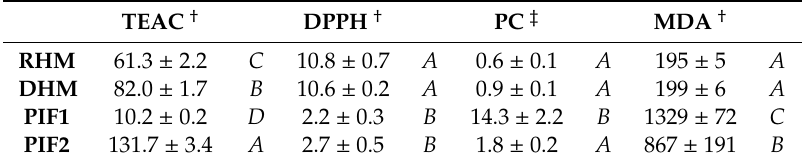
Table 2. Selected oxidative status indicators (means ± standard deviations; n = 3) for di ff erent preterm foods (100 mL). TEAC † DPPH